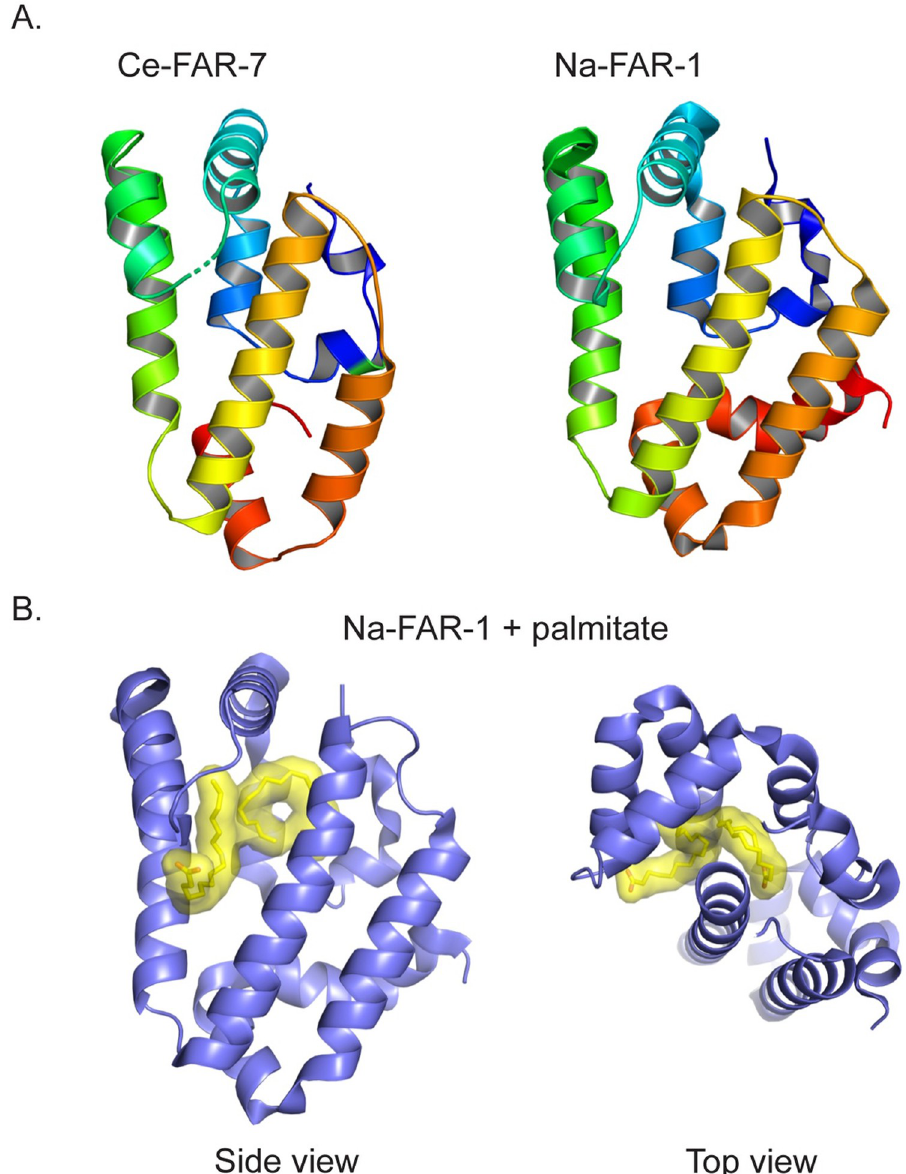
Fig 2. Secondary structure representations of the fatty acid and retinol binding proteins Ce-FAR-7 from C . elegans and Na-FAR-1 from N . americanus . (A) Rainbow color scheme of Ce-FAR-7 (2W9Y) and Na-FAR-1 (4XCP) ranging from blue (amino terminus) to red (carboxyl terminus) that highlights the conserved alpha-helical fold. (B) Side and top views of NA-FAR-1 bound to palmitate (yellow surface) that highlights the large central ligand binding cavity. Structure figures were generated using PyMOL (www.PyMOL.org). FAR, fatty acid–and retinol-binding